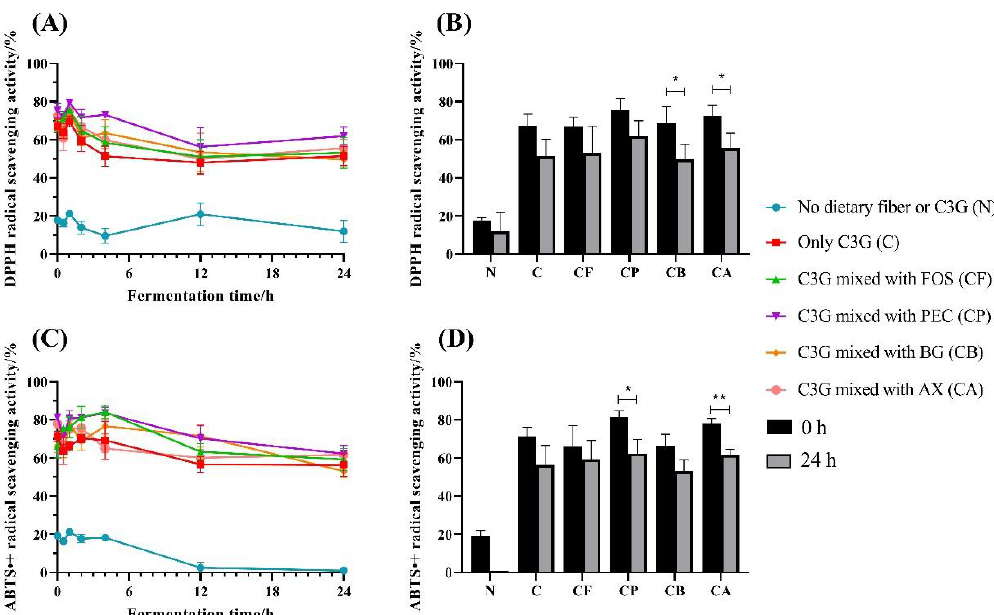
Figure 1. Changes in antioxidant activity, DPPH ( A ), and ABTS •+ ( C ) radical scavenging rate for C3G mixed with different polysaccharides during in vitro fermentation; differences in DPPH ( B ) and ABTS •+ ( D ) radical scavenging rate in vitro fermentation for 0 and 24 h. Asterisks indicate significant difference between fermentation for 0 and 24 h, according to an ordinary one-way ANOVA: * ( p < 0.05) and ** ( p < 0.01). Values are means ± SD for n = 3.